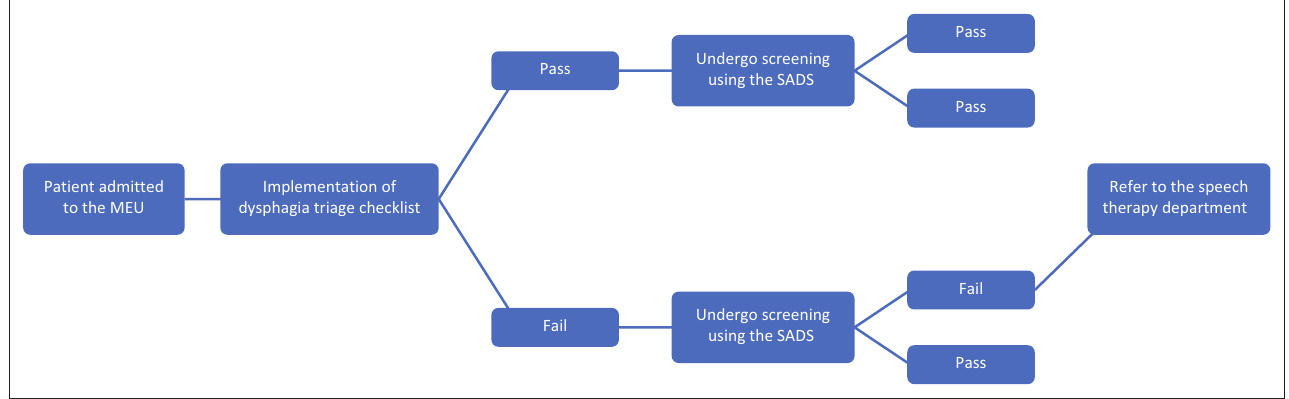
FIGURE 2: Procedure followed for patients admitted to the Medical Emergency Unit at the